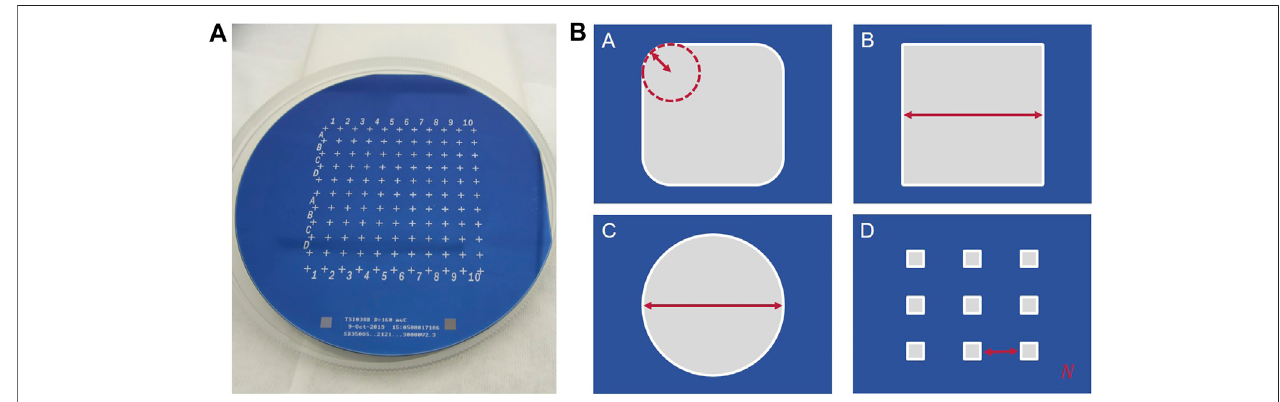
FIGURE4| Overviewofthesamplewithnanoformstructures. (A) Waferwithcolumnsandrows.Structureparametersarevariedoverthecolumns. (B) Sketchesof the structures in the different rows. Red arrows highlight which parameters are varied. (i) : Corner rounding of fi xed size squares. (ii) : Size of squares. (iii) : Size of circles. (iv) : Pitch and number ( N ) of structures in a small array.